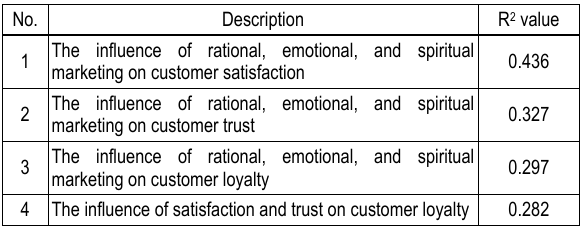
Table 4. Result of determination test of path analysis